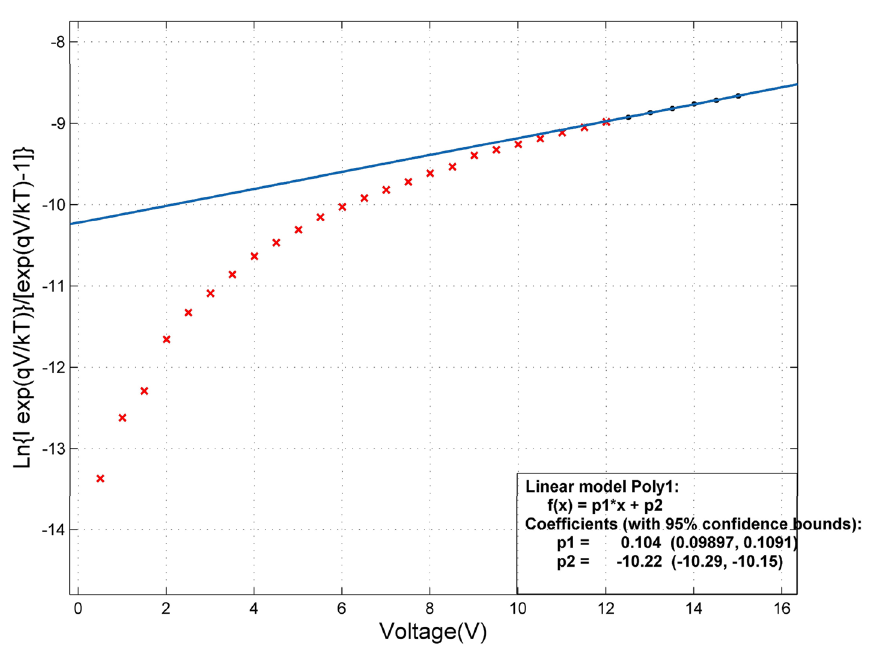
Figure 7. Curve fitting in MATLAB software and obtain Ln (I 0